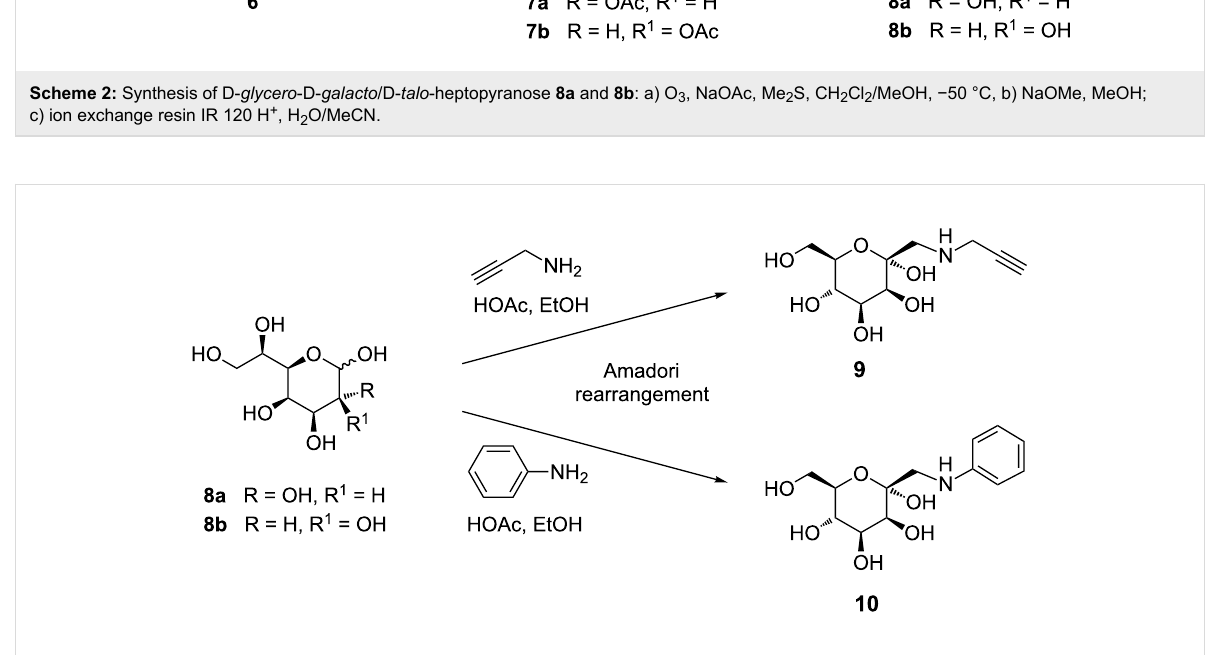
Scheme 3: Amadori rearrangement of heptoaldose 8 with propargylamine and aniline to yield C -glycosyl-type D-mannoside derivatives 9 and 10 , res-